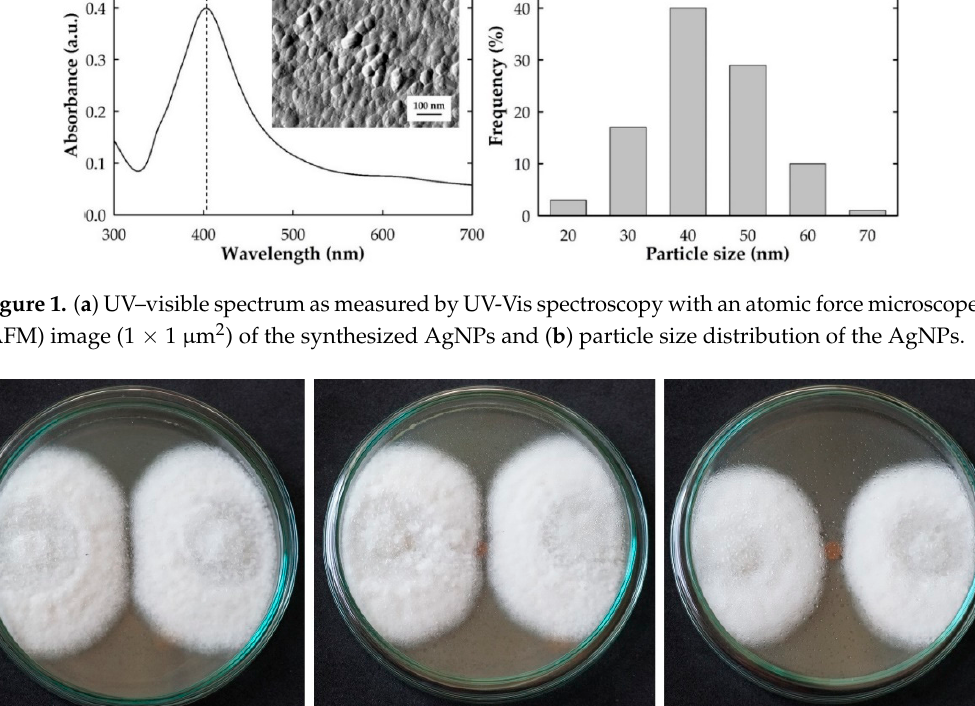
Figure 2. Antifungal activity in a control plate (no AgNP coating) and test plate with different concentrations of AgNPs coated paper, for 7 days of incubation.